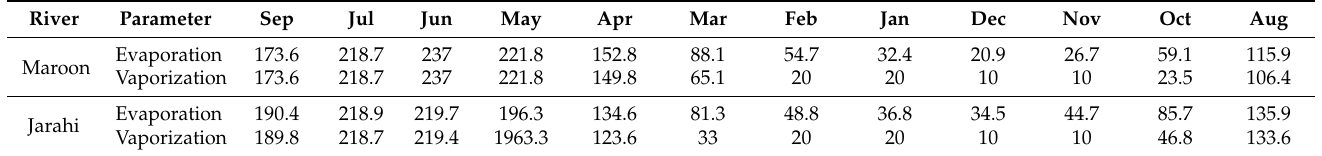
Table 1. Potential evaporation during the sampling period (mm).